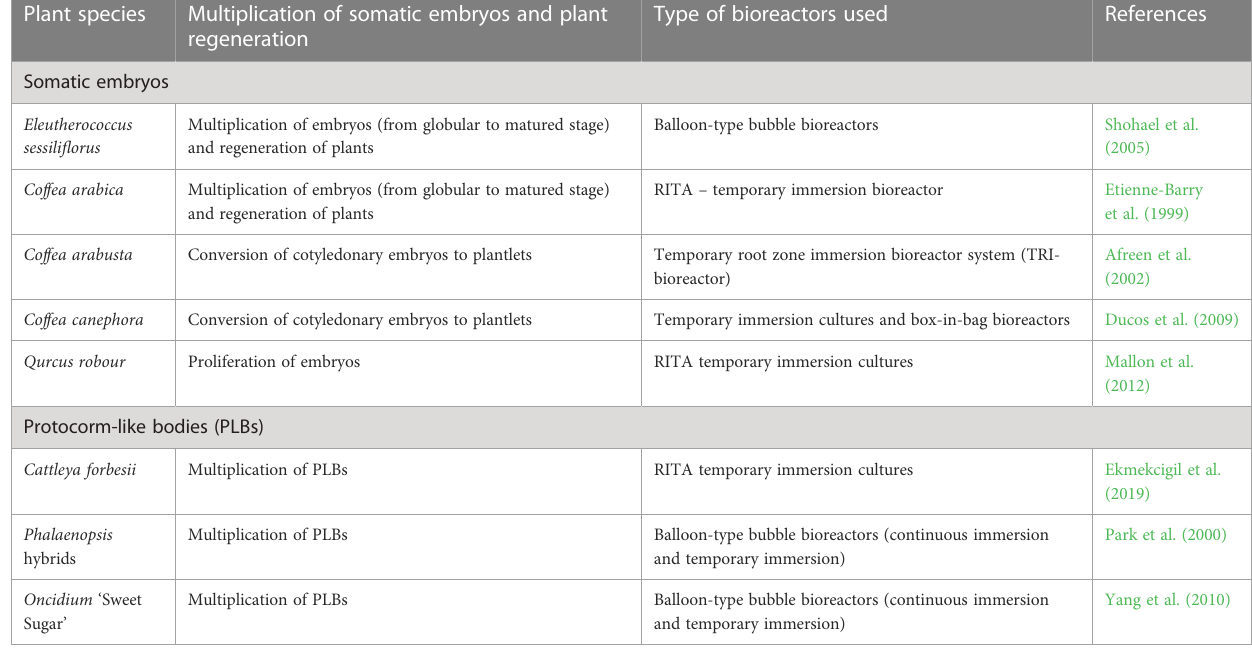
TABLE 4 Selected examples of multiplication of somatic embryos and plant regeneration in bioreactors. Plant